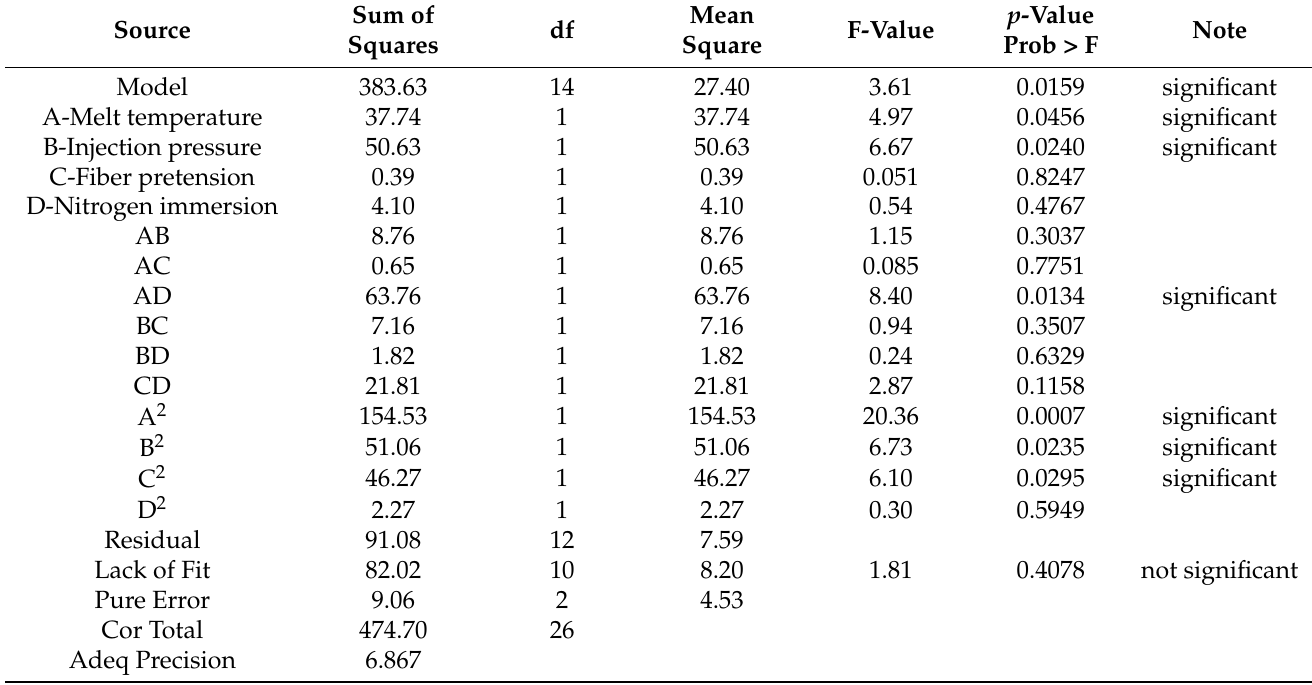
Table 8. ANOVA for